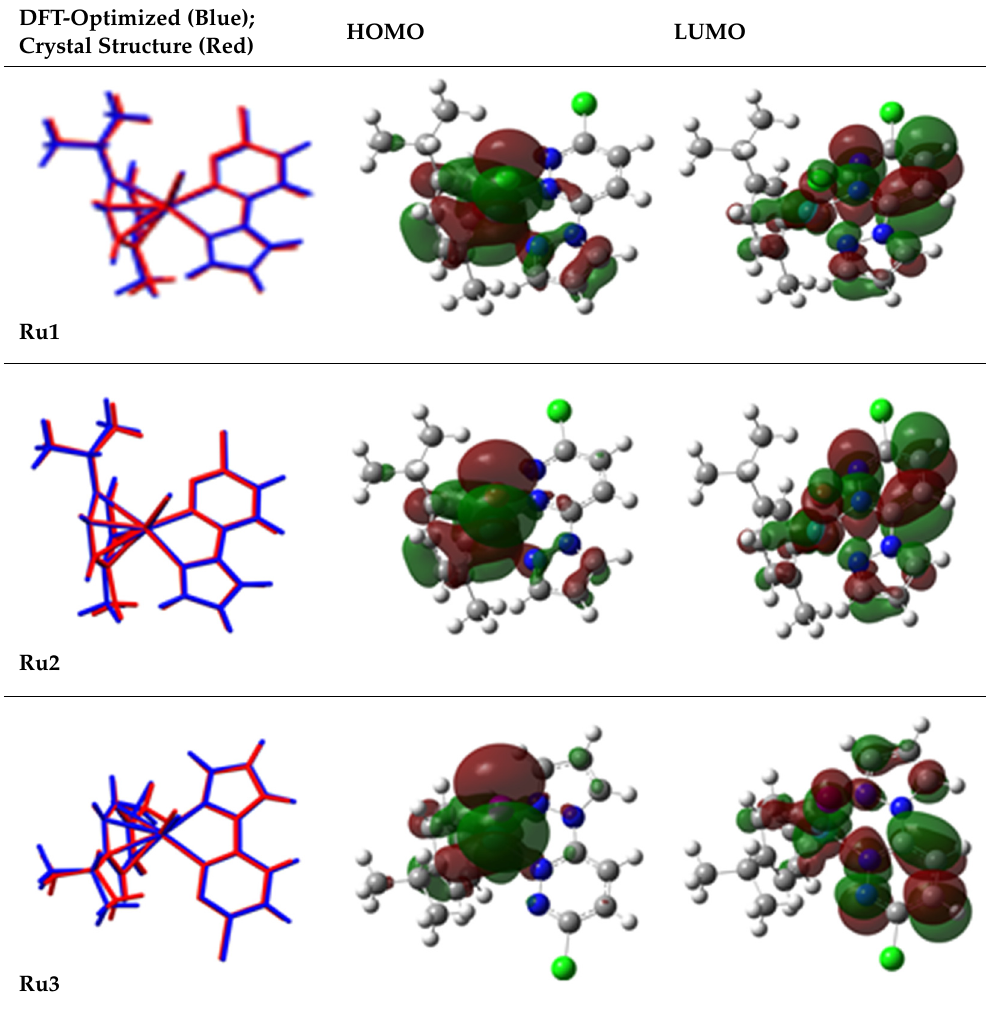
Table 4. Overlays of the geometry-optimized structures on their crystal structures, and HOMO and LUMO electron density mappings for Ru1-3.